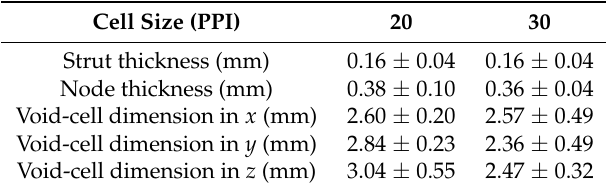
Table 3. Geometric characteristics of the studied